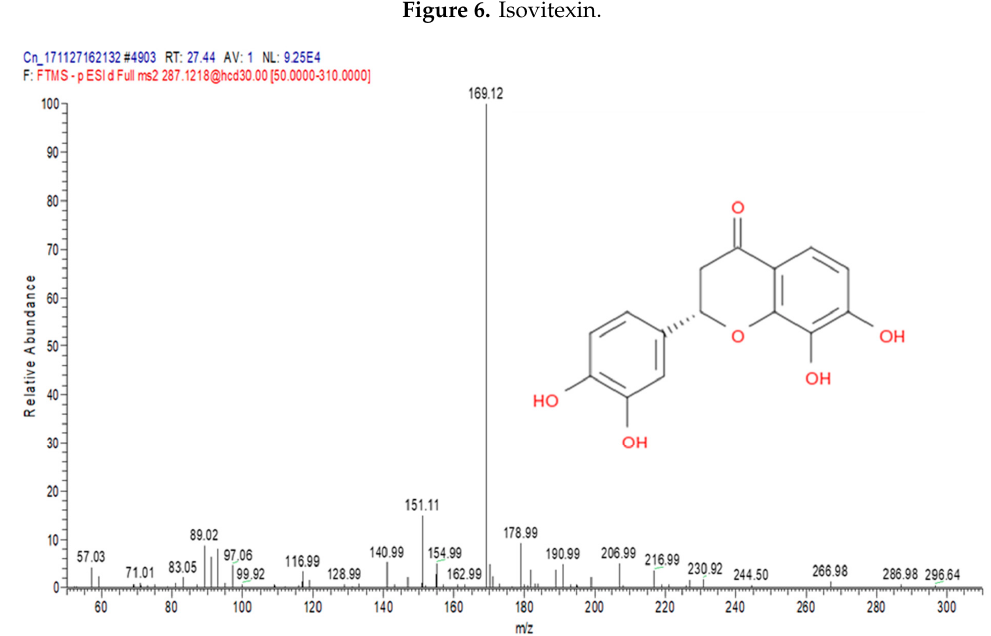
Figure 6. Isovitexin.